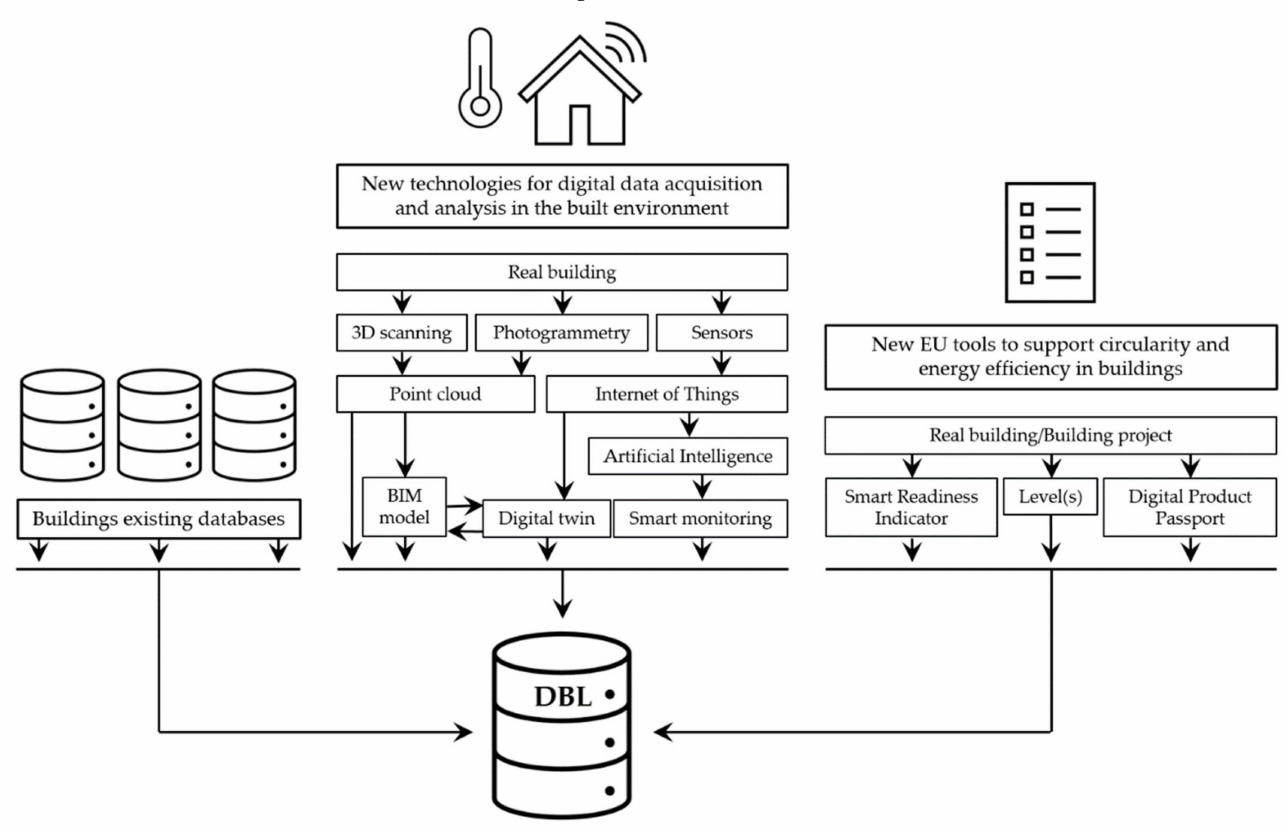
Figure 2. Inputs of the Digital Building Logbook from existing and new data sources. Source: adaptation from The Digital Building Logbook as a gateway linked to existing national data sources: The cases of Spain and